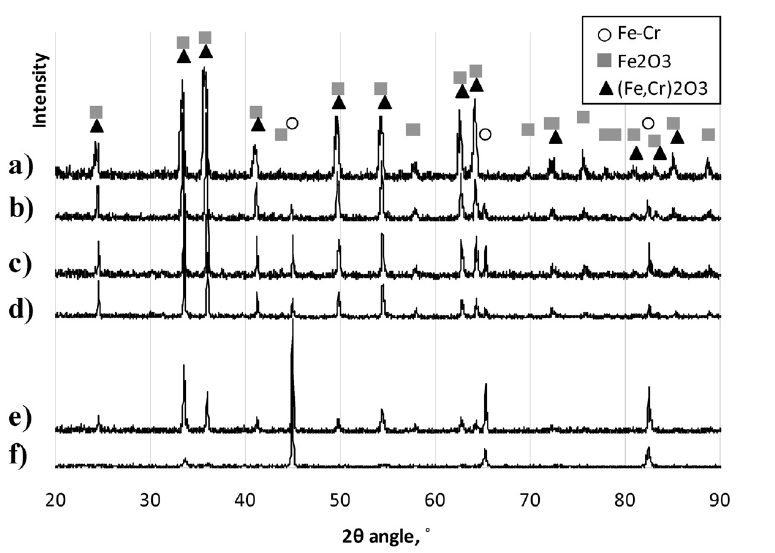
Figure 14. XRD spectra for uncoated specimens after 336 hours exposure in atmosphere indicated in brackets (Table 2).